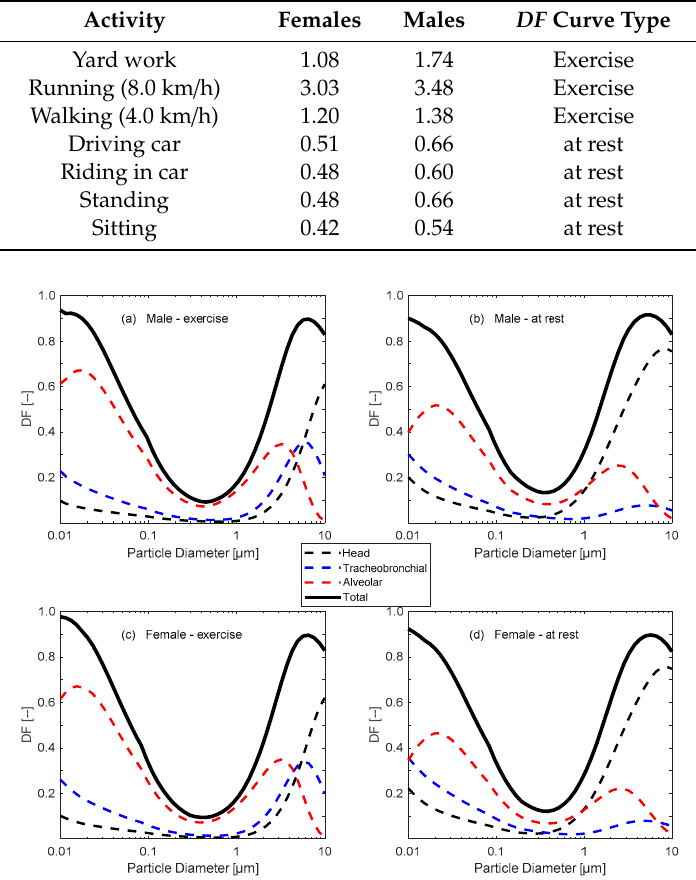
Table 1. Minute ventilation (volume of air breathed), V E [m 3 /h], for adult subjects according to Holmes [50]. The last column indicates the deposition fraction curve used for that activity (Figure 1).